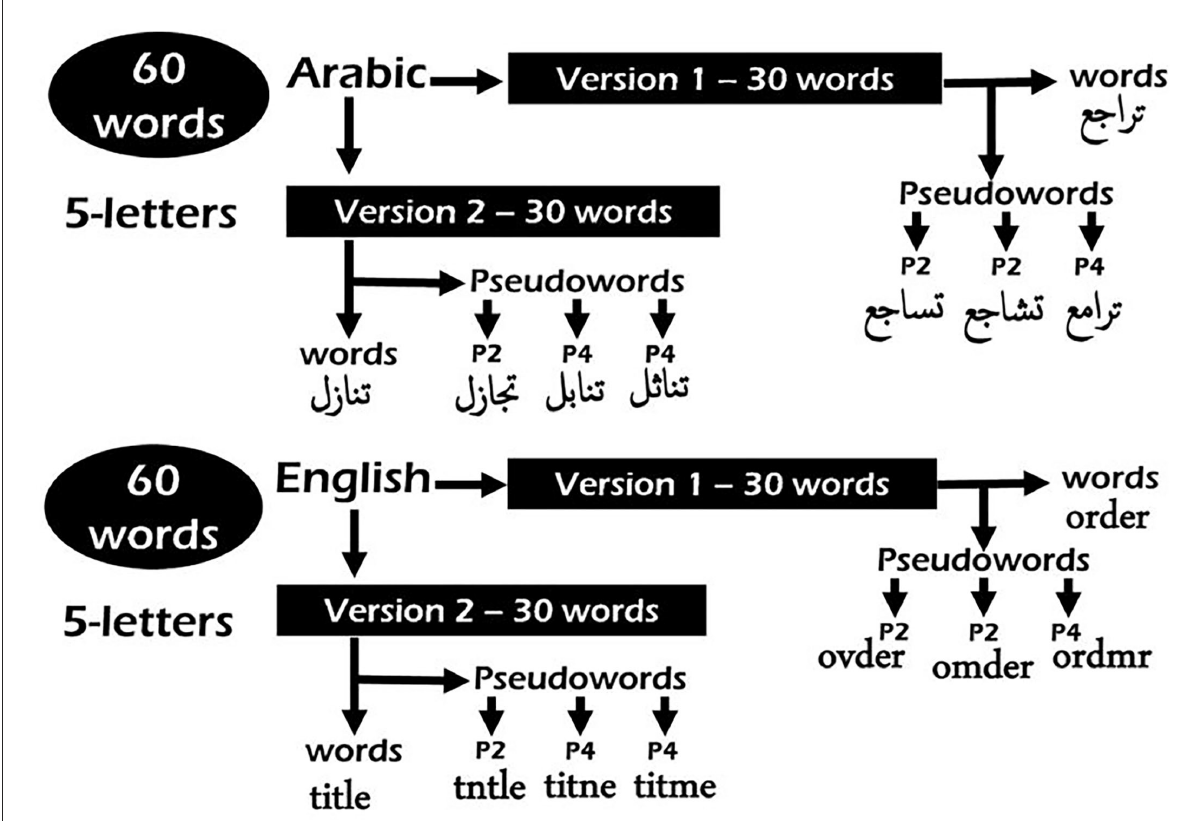
FIGURE2 Examples of pseudo-words generated in Arabic and English from their corresponding word stimuli. See Appendix for the complete list of